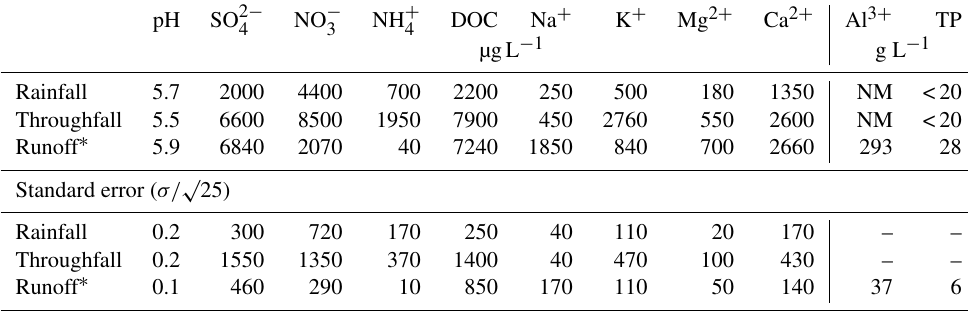
Table 1. Average hydrochemical data 2012–2013 (following Oulehle et al.,